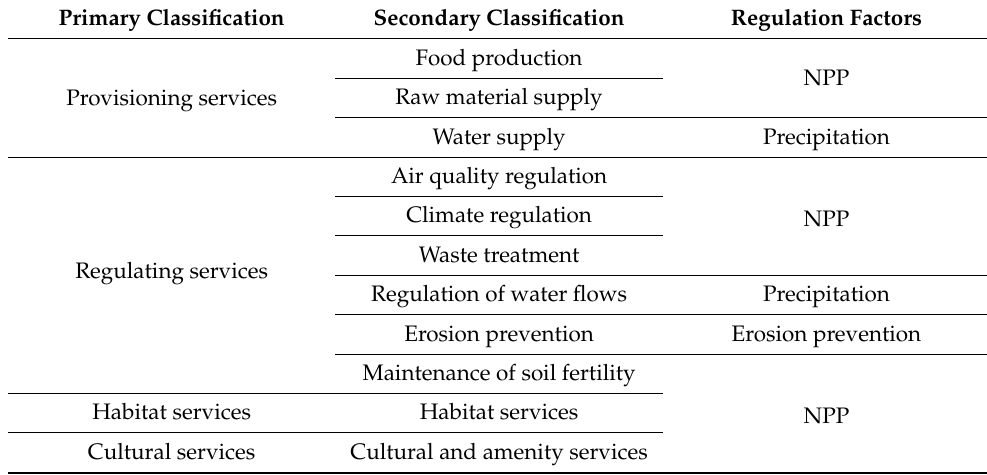
Table 2. The regulation factors of different types of ecosystem services